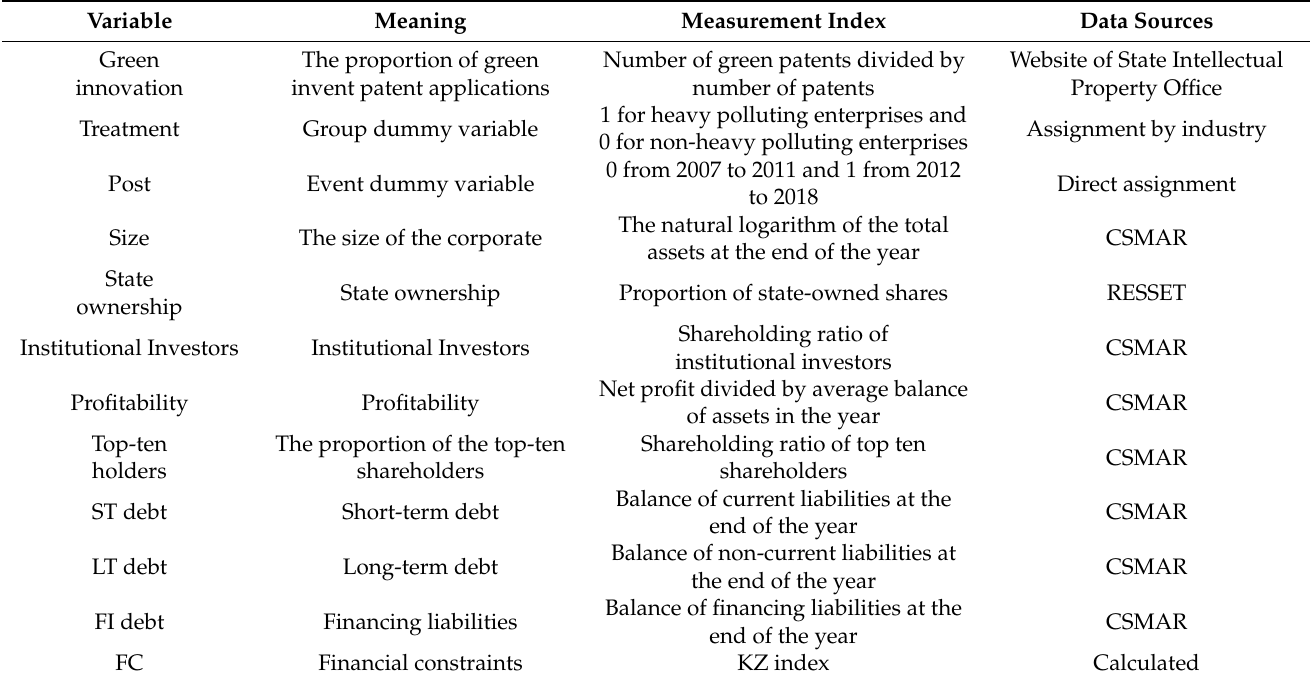
Table 1. Main variables, measurement indicators, and data sources.